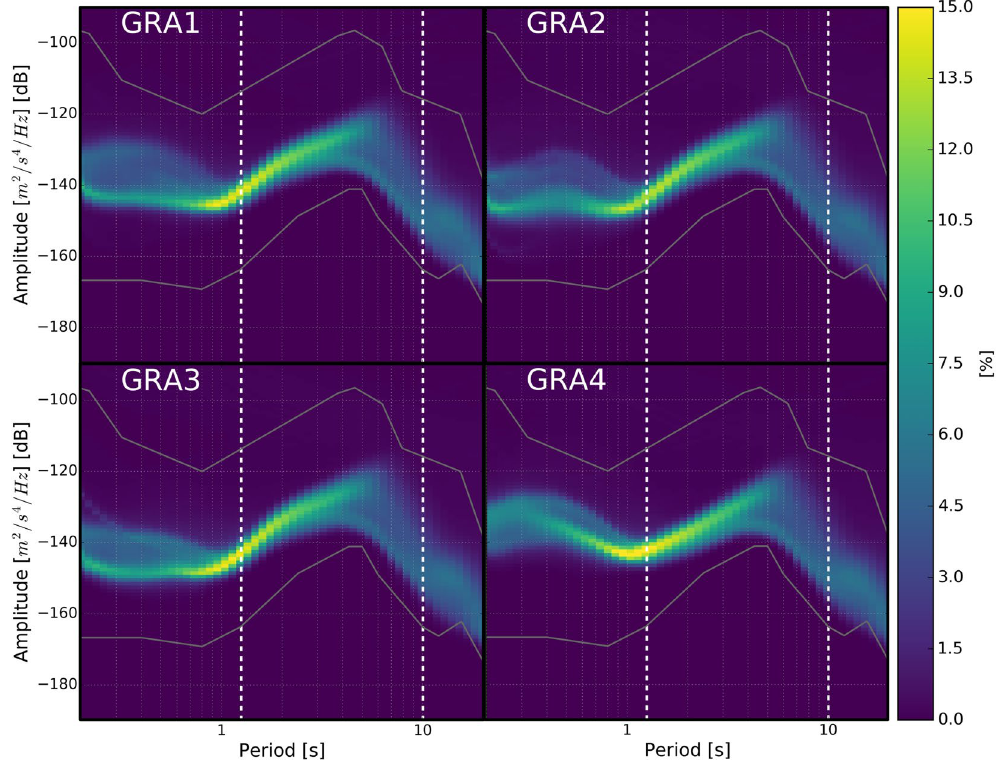
Figure 6. Probabilistic power density spectrum (PPSD) of the vertical component (BHZ) records from the 4 stations used in this study. PPSDs are constructed from 1 hour individual PSDs, overlapping by 50%. The time span shown here includes all data available between 1977 and 2006, i.e. more than 500.000 individual Power Spectral Density (PSD). At each pixel (i.e. given period and amplitude), the color scale shows the percentage of spectra that fall into the pixel. The data acquired by the stations has been band-passed at acquisition time between 0.05 Hz and 5.0 Hz, so only this range is presented here. The frequency band used for the dv/v calculation is comprised between the white dashed lines, from between 1.25 s and 10 s. The New High or Low Noise Models 43 are shown for reference.